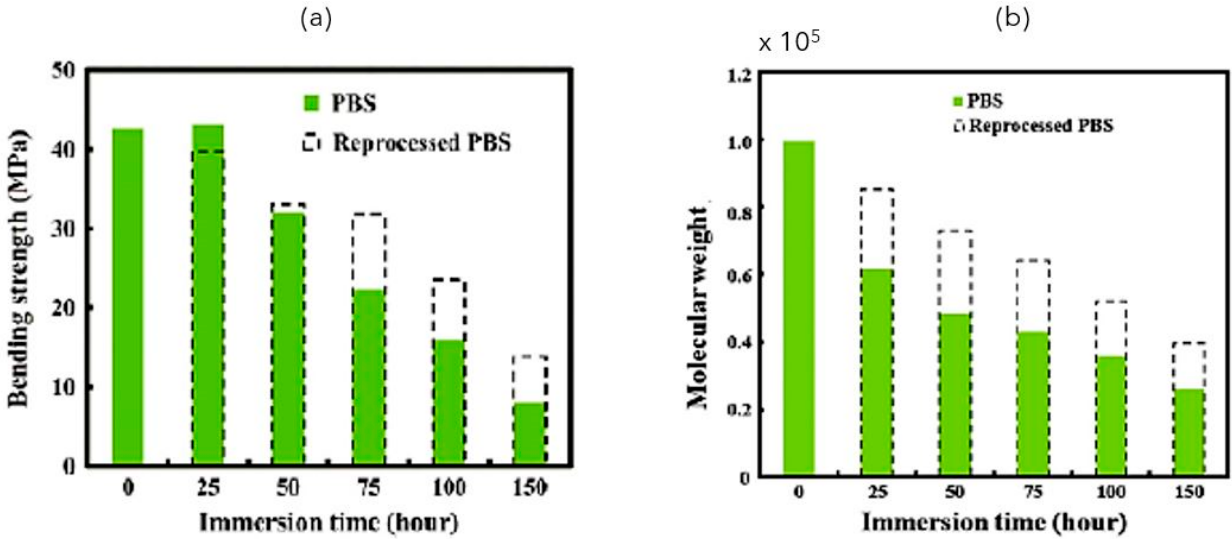
Figure 10. ( a ) Bending strength and ( b ) Molecular weight of PBS and reprocessed PBS [Reprinted with permission from Reference [138] Copyright 2012 Elsevier].